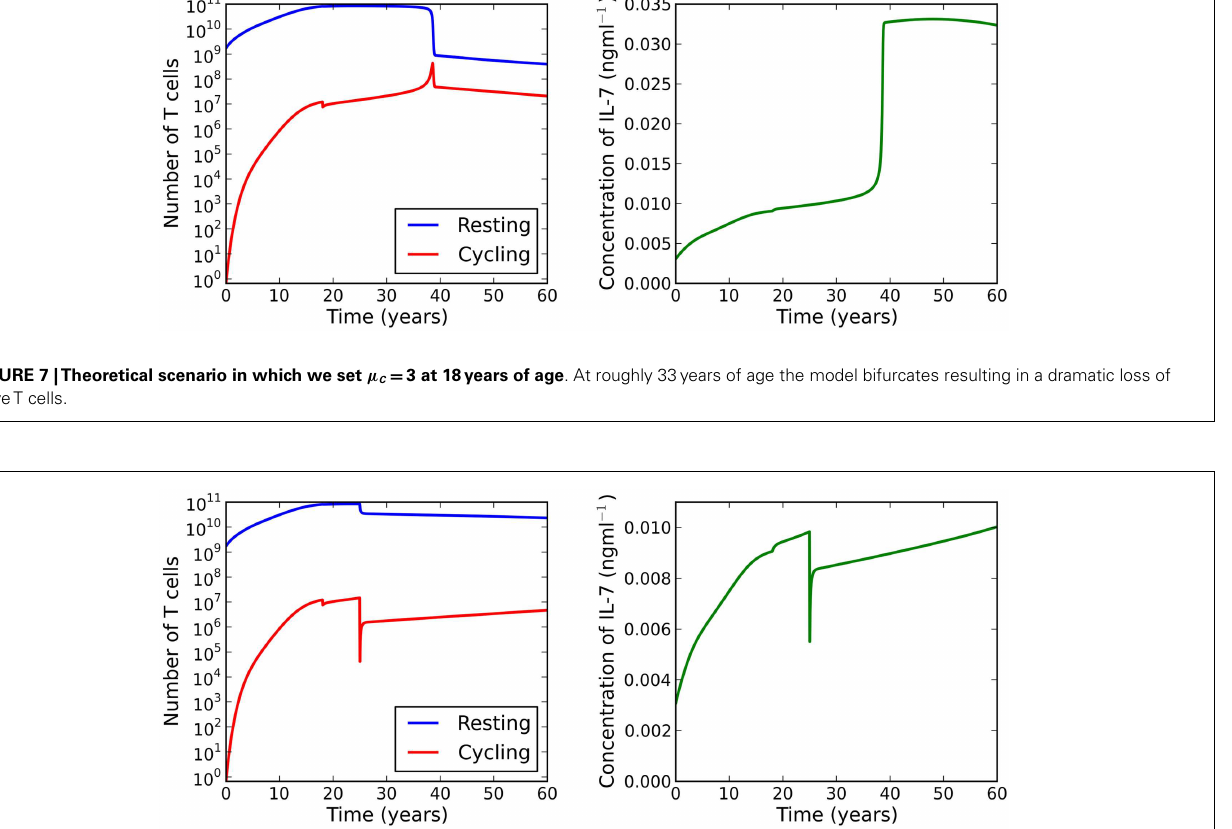
age.Whilst theT cell count is reduced, this attrition is a significant improvement on the reduction observed when the individual has not received treatment (see Figure 7